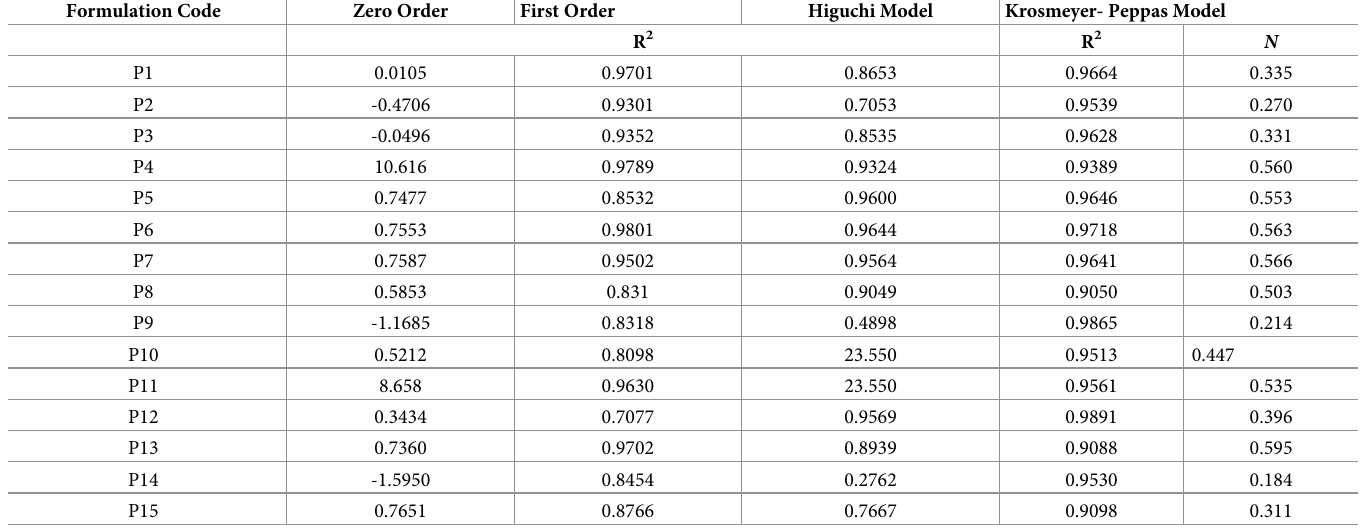
Table 4. Values of correlation co-efficient of different kinetics models on release data. Formulation